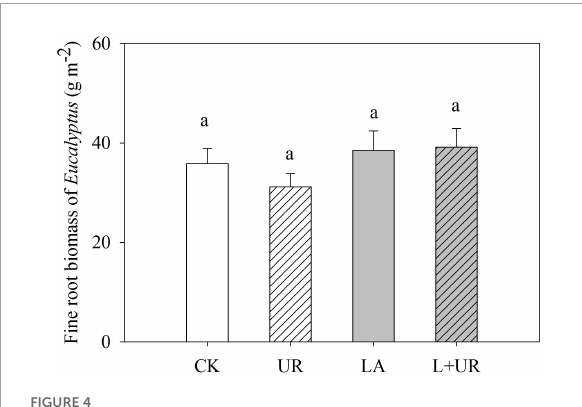
FIGURE4 Eucalyptus fine root biomass after treatments were applied 8 month. Values are means with standard errors, n = 3. Different lowercase letters indicate significant difference ( P < 0.05).